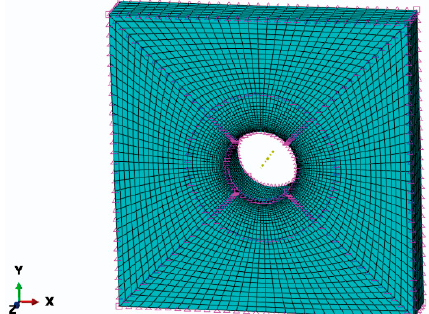
Figure 5. Single-hole specimen hole edge area meshing.